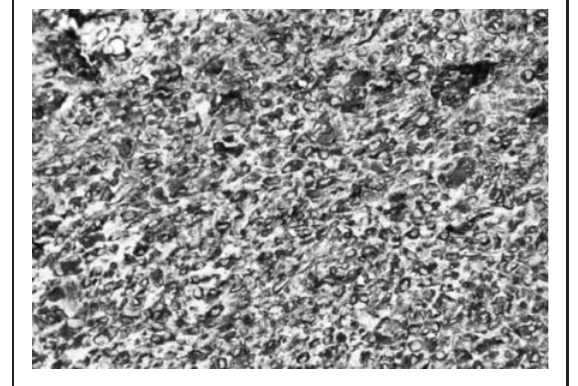
Figure 4. Sheets of tumor cells, positive for